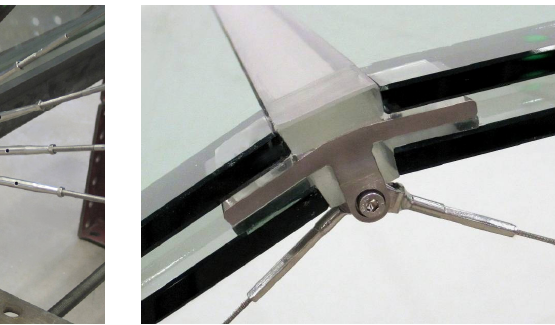
Figure 10: Support of the constructed prototype Figure 11: Front view of the prototype